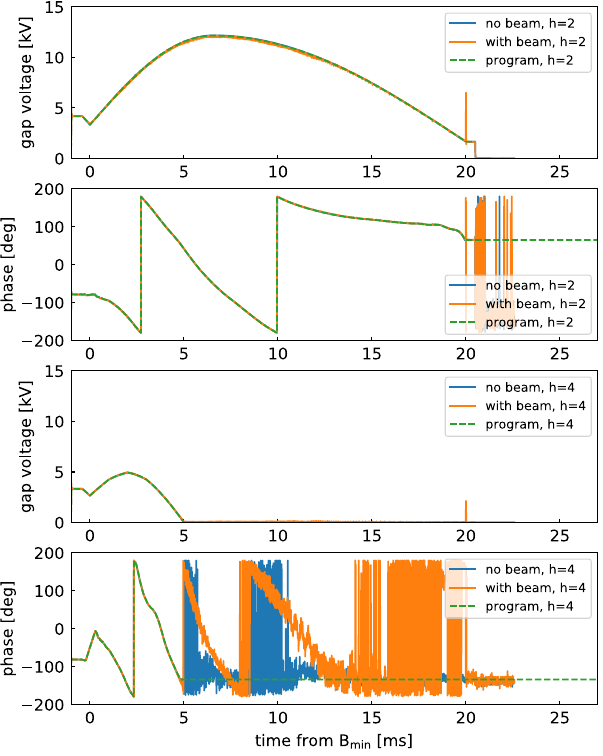
FIG. 34. Comparison of the amplitudes and phases of the driven harmonics ( h ¼ 2 , 4) to the programs without and with a